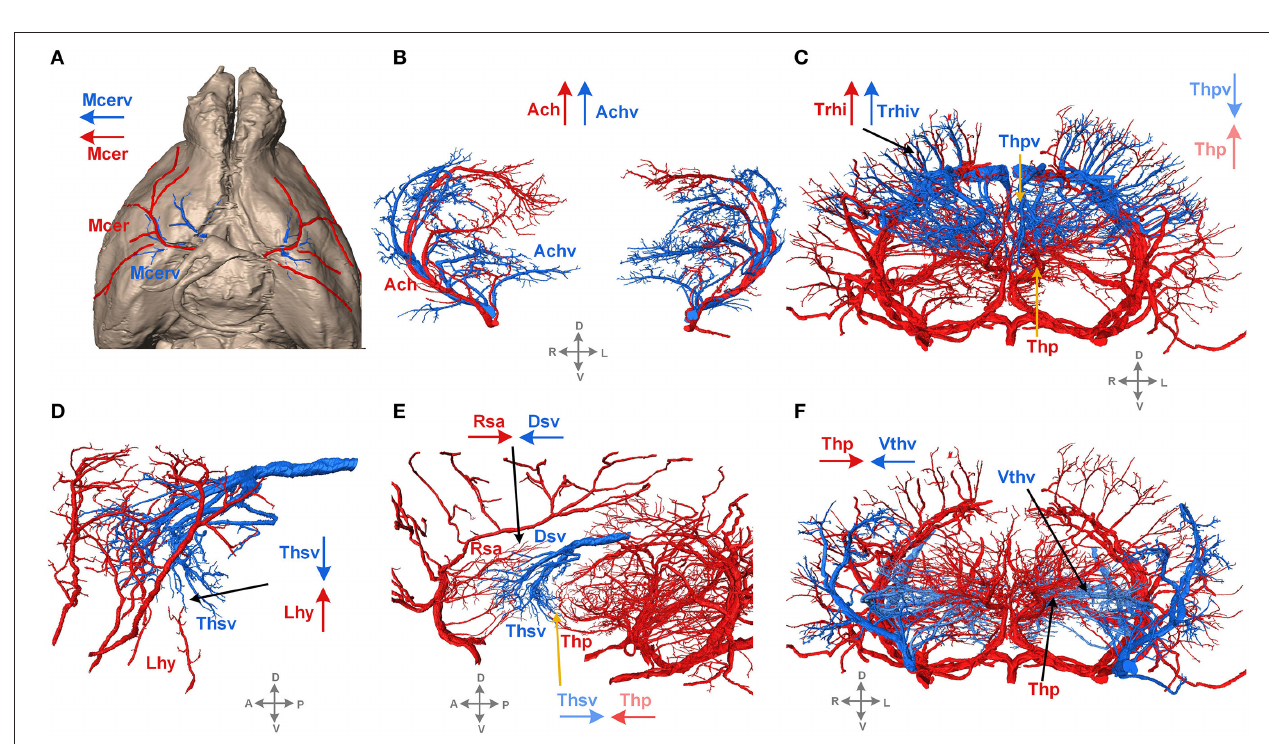
FIGURE 7 | Typical distribution patterns of arteries and veins. Arteries are presented in red, and veins are in blue. The arrows in red and blue indicate the characteristics of the extending direction. D, dorsal; V, ventral; L, left; R, right; A, anterior; P, posterior. A tree of abbreviations and the full names of the vessels is presented in Figure 4 . (A) The distribution patterns of vessels on the brain surface. (B–F) The distribution patterns of vessels inside the brain.